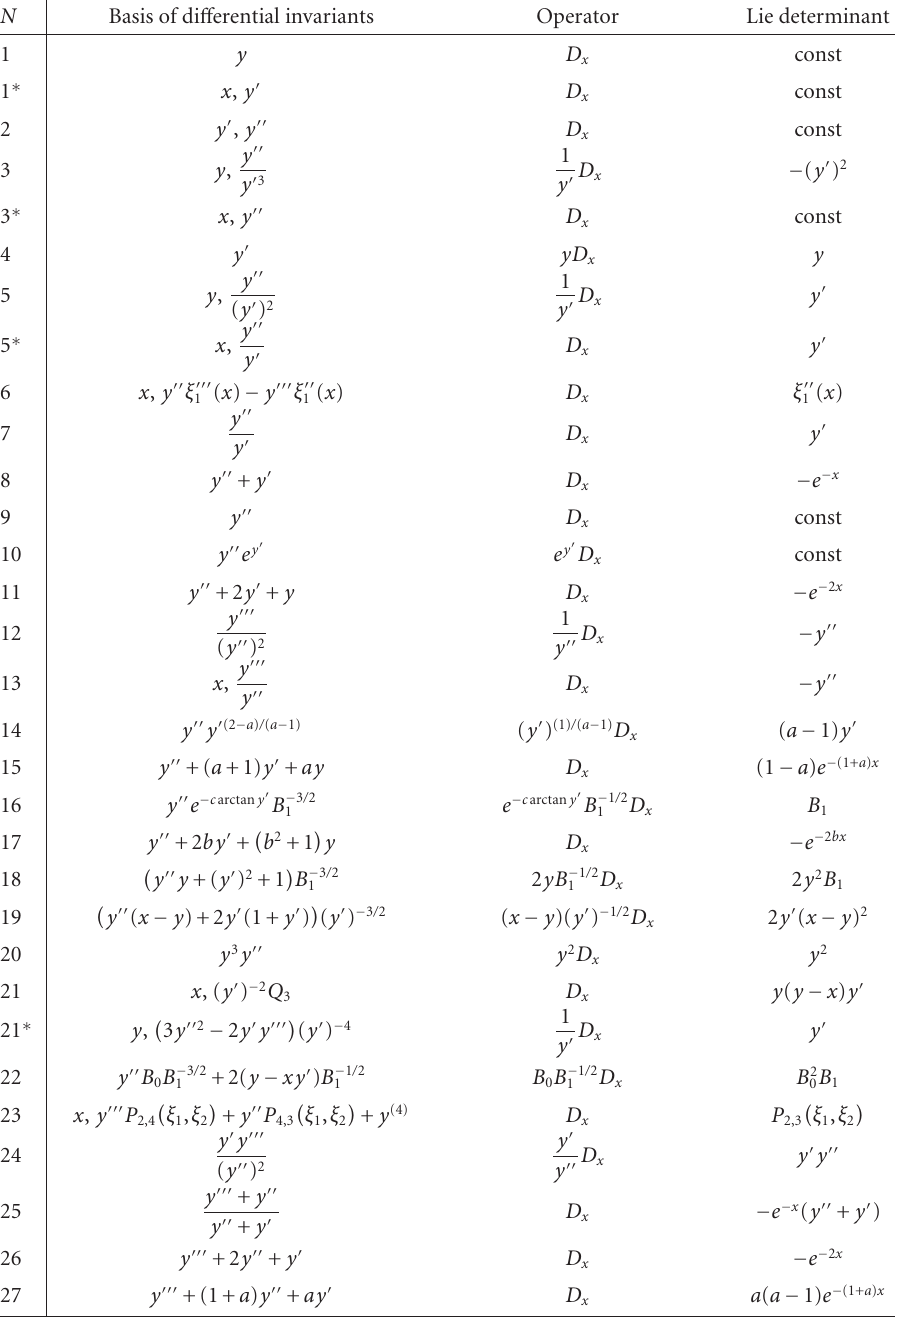
Table 1.3. Di ff erential invariants, operators of invariant di ff erentiation, and Lie determinants of real- izations of Lie algebras on the real